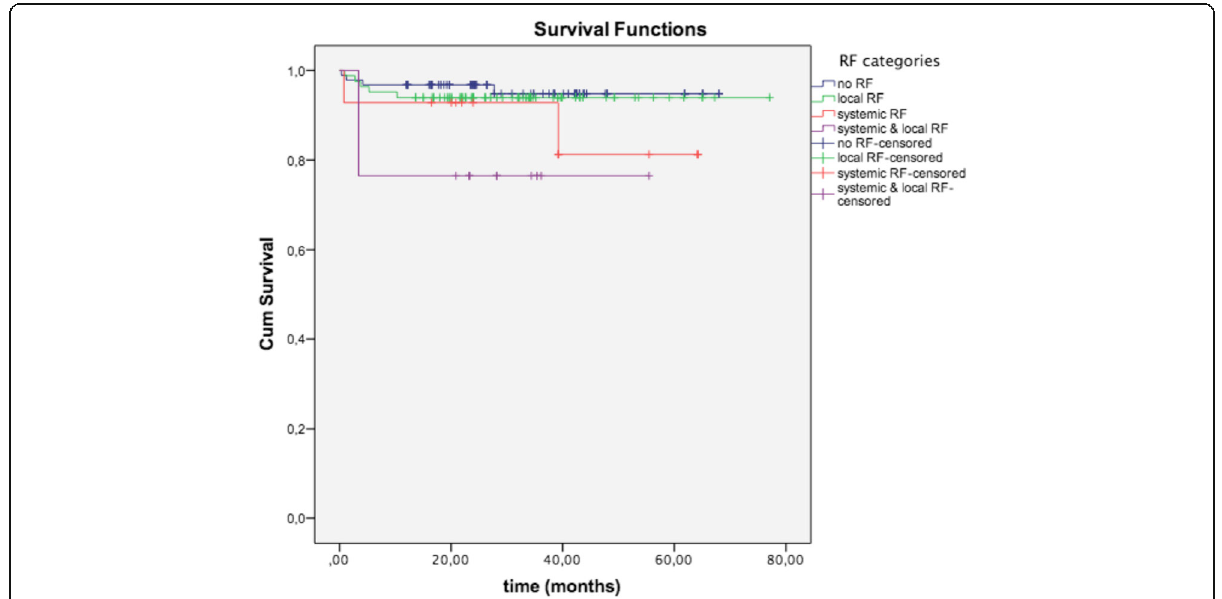
Fig. 2 The cumulative survival rates for the different RF groups revealing a significant difference for patients without any and patients with local and systemic RFs (log rank, p =